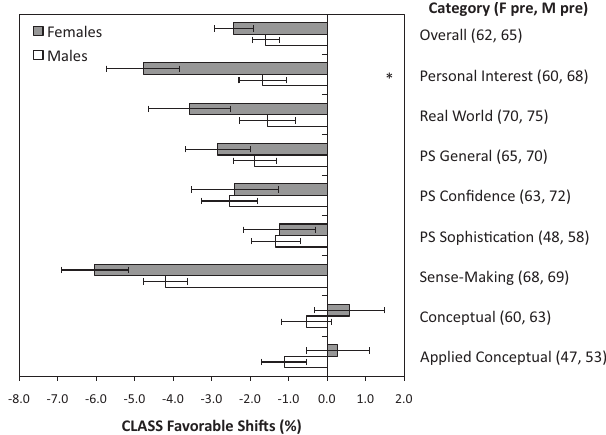
FIG. 4. Average shifts (cid:1) post–pre (cid:2) for males and females in Phys- ics 2 on each of the CLASS categories. Note that all shifts are negative or zero, meaning both male and female students shift to- ward less expertlike attitudes and beliefs about physics or remain the same. The asterisk (cid:1) (cid:1) (cid:2) indicates that the difference in shifts for males and females is significant (cid:1) p (cid:1) 0.05 (cid:2) . Values in parentheses (cid:1) on the right hand side (cid:2) are female and male average pretest scores. The pretest scores of males and females are significantly different in all categories except